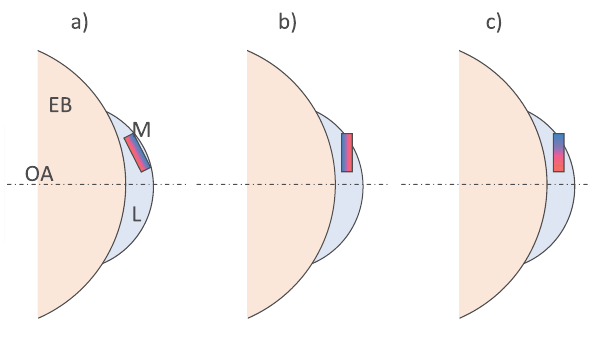
Figure 6. Schematic representation (not to scale) of an eye-ball (EB) (OA is its optical axis) wearing a lens (L) with a magnetized disk (M) embedded. The red–blue colors represent the M magnetization. In the current implementation ( a ), the disk is axially magnetized and is inserted tangentially to the lens, a few mm displaced from the optical axis. This reduces the magnet encumbrance, at expenses of a ˆ m − ˆ e misalignment and consequent need of indirect gaze retrieval. Constructive efforts can be devoted to make the dipole parallel to the gaze direction ( b ) or perpendicular to it ( c ). This would simplify the data elaboration and—in the case ( c ), i.e., with a diametrical magnetization—it would make the system highly responsive to torsional movements: an unprecedented feature of this methodology. As sketched, the ( b , c ) arrangements may present issues to guarantee a complete magnet embedding). For simplicity, the angle kappa is neglected in these figures: the optical and visual axes are represented as